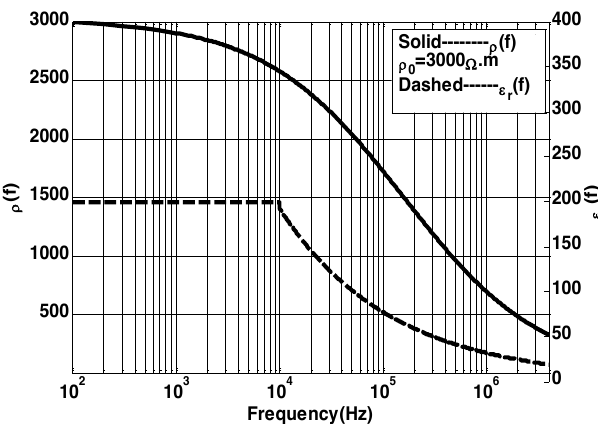
Figure 11: Frequency variation of electrical parameters of soil for low-frequency resistivity .